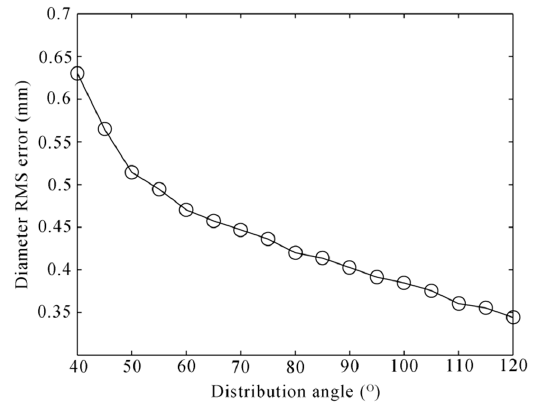
Figure 13. Diameter RMS error to the distribution angle of the lasers on the wheel rim plane.